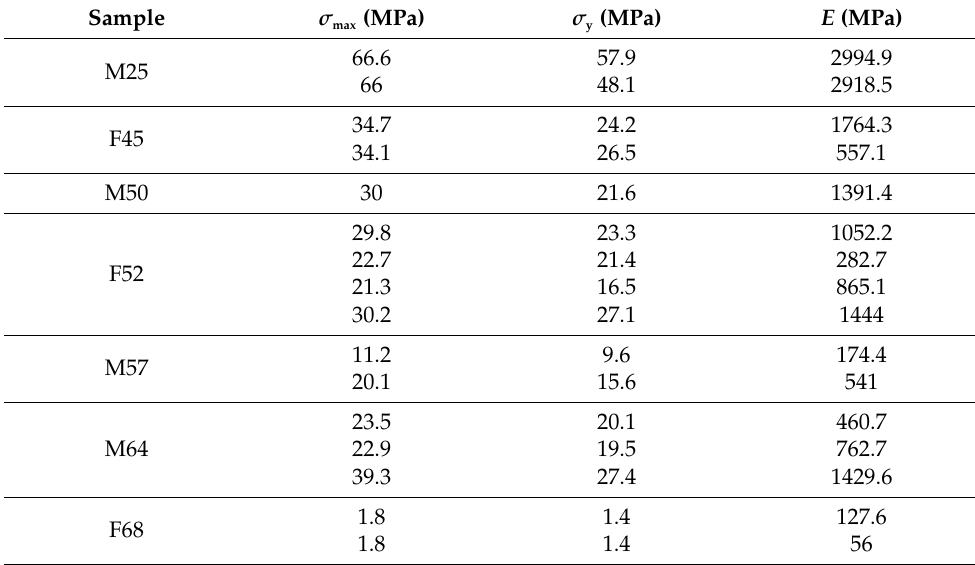
Table 2. Results of mechanical tests for each sample